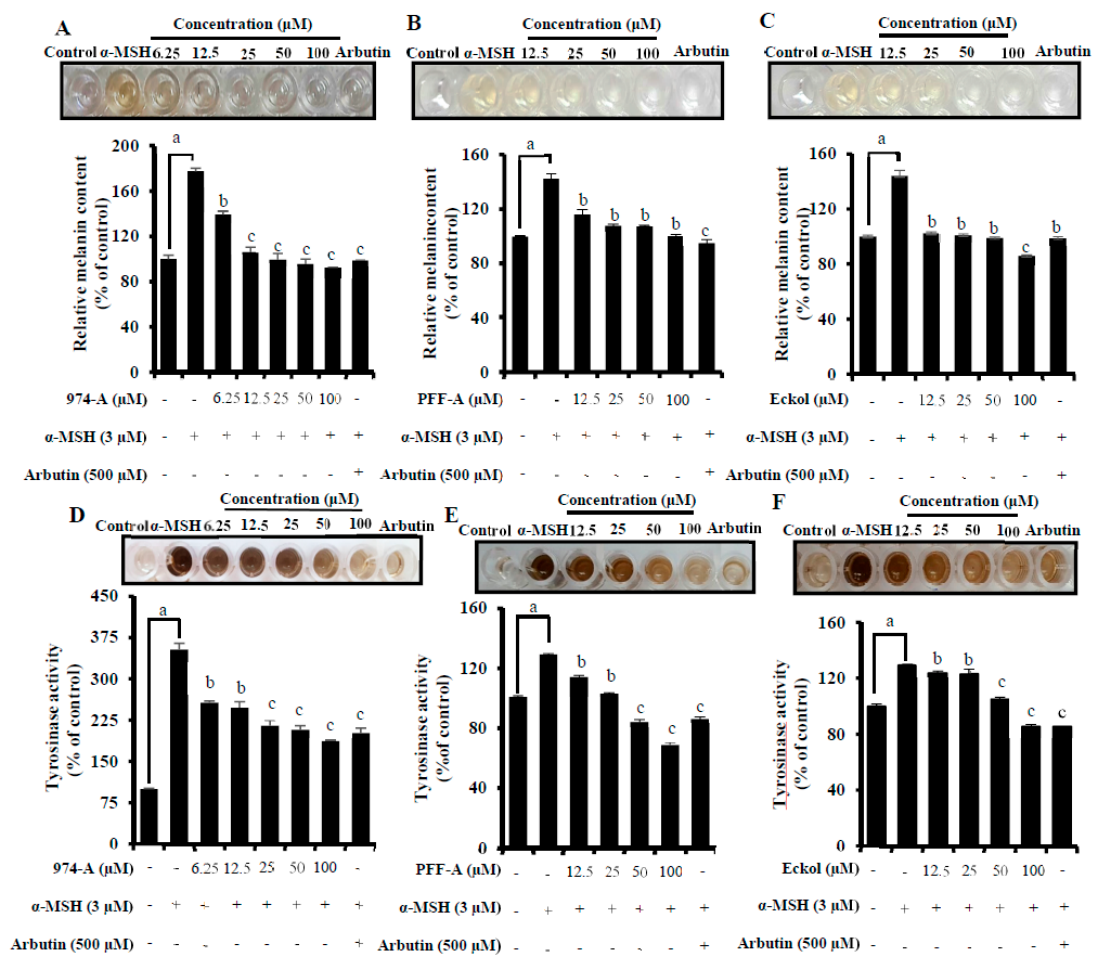
Figure 3. Effects of various concentrations of 974-A ( A , D ), phlorofucofuroeckol-A (PFF-A) ( B , E ), and eckol ( C , F ) on the melanin content and tyrosinase activity, respectively, of α -MSH treated B16F10 melanoma cells. Cells were pretreated with the indicated concentrations (6.25, 12.5, 25, 50, and 100 µM) of 974-A, PFF-A, and eckol for 1h followed by exposure to α -MSH (3.0 µM) for 24h in the presence or absence of the test compound. Arbutin (500 µM) was used as a positive control. Data represent the mean ± SD of three independent experiments. a p < 0.01 indicates significant differences from the normal control group (no treatment); b p < 0.05, c p < 0.01, and d p < 0.001 indicate significant differences from the α -MSH treated group.